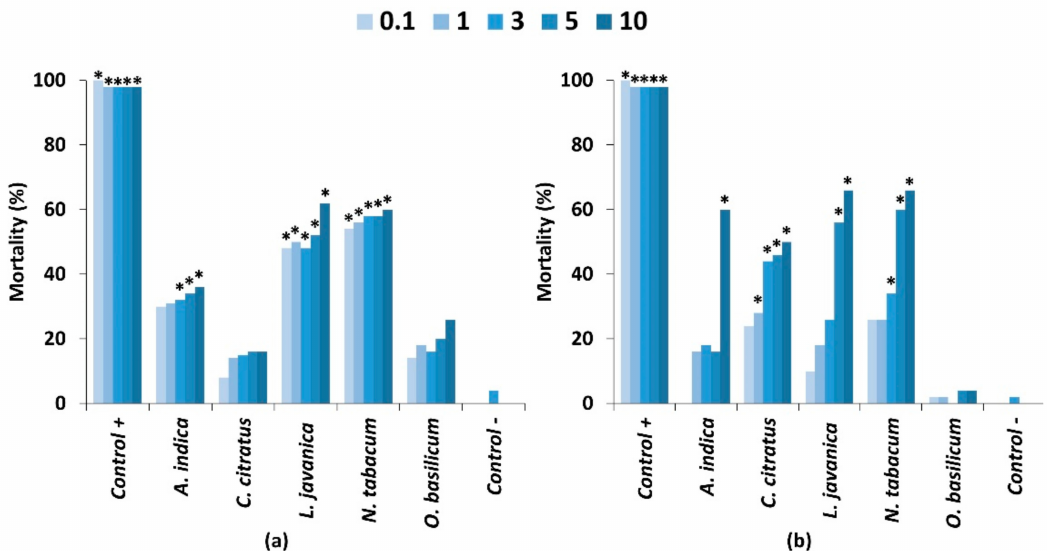
Figure 2. Mortality of fall armyworm 2nd instars seven days after exposure to five di ff erent concentrations of pesticidal plant extracts when applied through ( a ) a feeding bioassay and ( b ) a contact toxicity bioassay. Treatments di ff ering significantly from the untreated control ( p < 0.05) are indicated by *. Significant di ff erences are presented in Table S1.